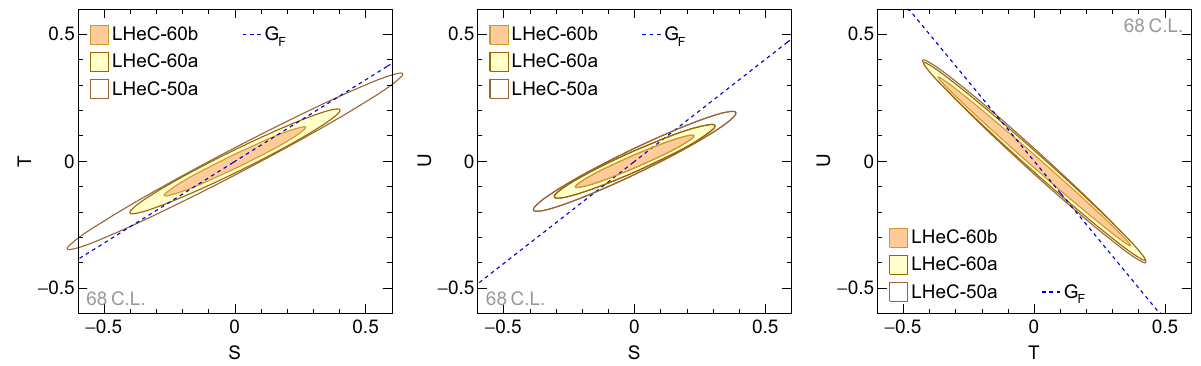
Fig. 9 Resultsof2-parameterfitstopairsof S , T ,and U where m Z and m W are fixed SM input parameters. For each choice of two of the three parameters S , T , or U , the third oblique parameter is kept equal to zero.